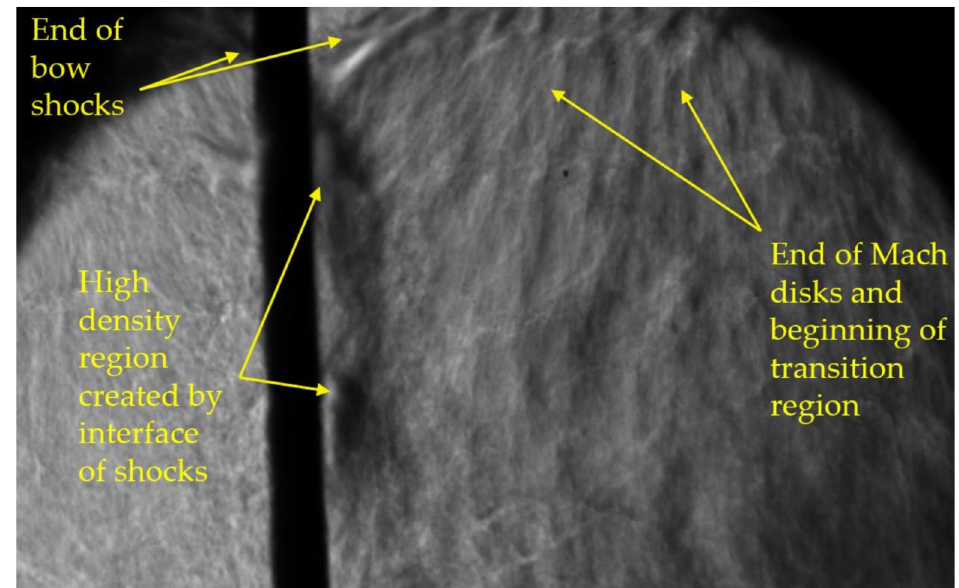
Figure 12. Schlieren of combining air jet ‘curtains’ below the poppet valves, slightly off center of the centrally mounted thermocouple, in the second optical setup, at 5.0 MPa and 1 mm valve lift.